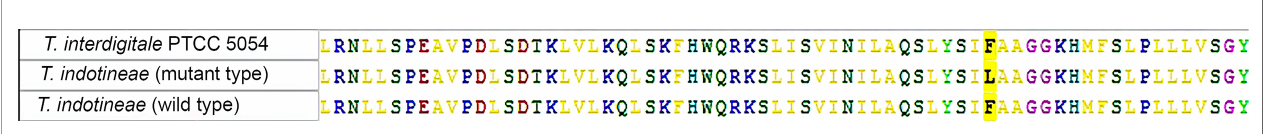
FIGURE 2 | Comparison of the amino acid sequence of squalene epoxidase in terbina fi ne-sensitive strain and terbina fi ne-resistant strain.